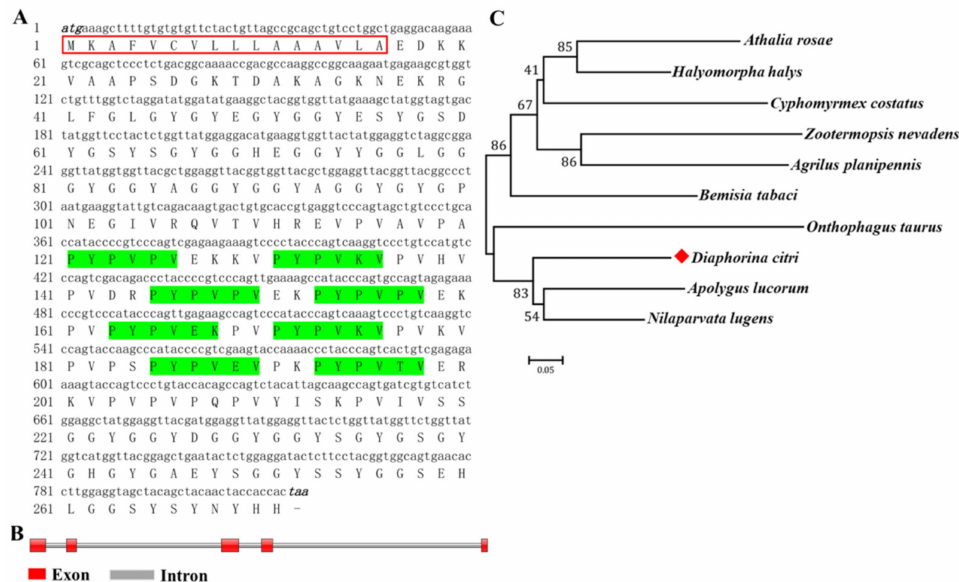
Figure 2. Bioinformatics analysis of DcCP64. ( A ) Complete nucleotide and deduced amino acid se- quence of D. citri CP64 ( DcCP64 ) cDNA. Numbers on the left side represent nucleotide and amino acid positions. The initiation codon (ATG) and termination codon (TAA) are indicated in black italics. The signal peptide sequence is indicated by a red box. Eight PYPV motifs are marked by a green region. ( B ) Gene structure analysis of DcCP64 by using Splign online software. ( C ) Phylogenetic relationships of DcP64 in different insect species using the neighbor-joining method with a bootstrap value of 1000. The protein accessions are as follows: Diaphorina citri (XP_008474070.1), Apolygus lucorum (KAF6213364.1), Bemisia tabaci (XP_018909777.1), Zootermopsis nevadensis (XP_021934705.1), Onthoph- agus taurus (XP_022901515.1), Agrilus planipennis (XP_018319890.1), Athalia rosae (XP_012251808.1), Nilaparvata lugens (XP_039293390.1), Halyomorpha halys (XP_014277355.1), and Cyphomyrmex costatus (XP_018400946.1). The red rhombus mark indicated Diaphorina citri